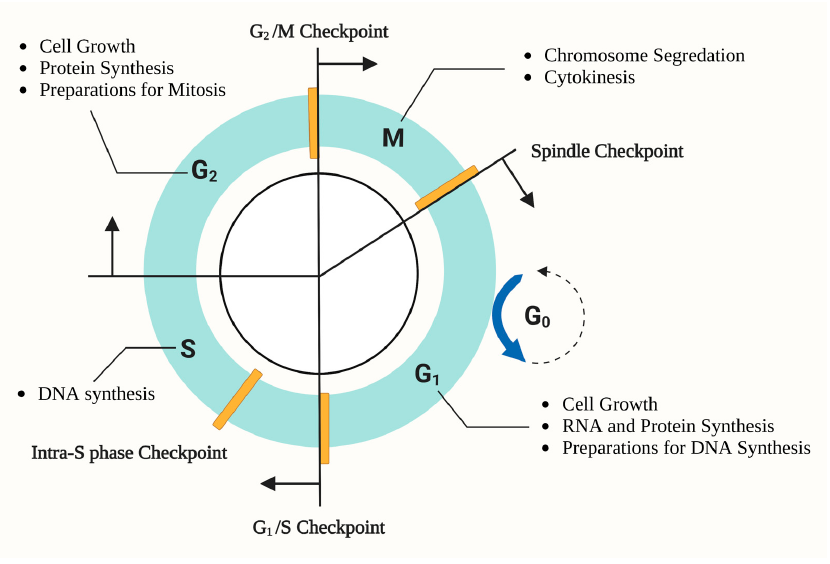
Figure 1. Features of the mammalian cell